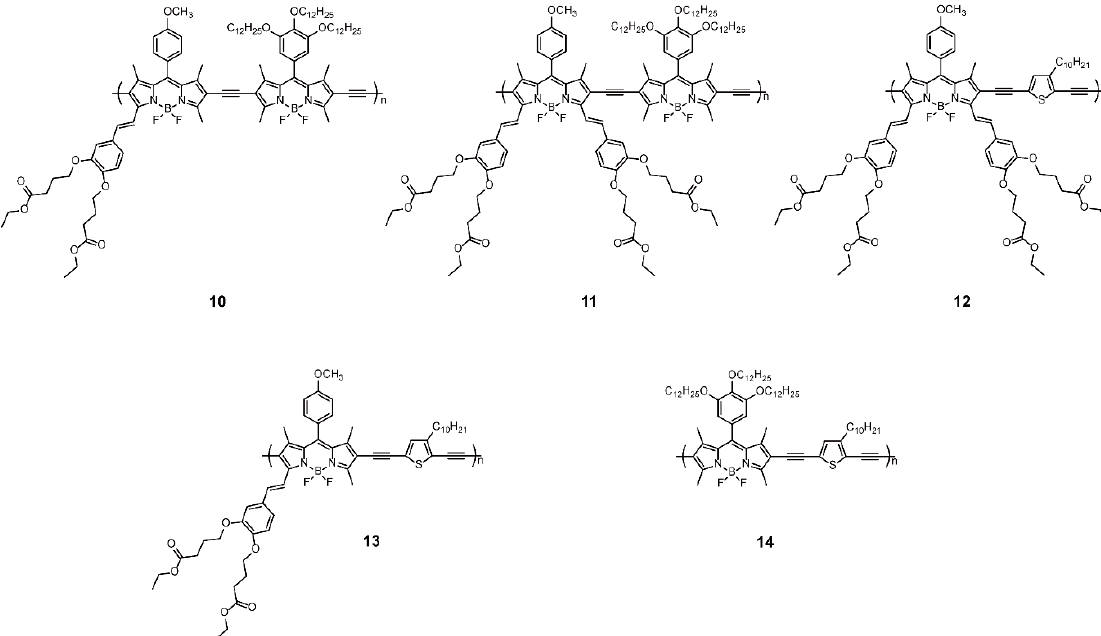
Figure 5. Chemical s tructures of polymers 15 and 16 ( Reproduced with permission from Reference [40]. Copyright @ 2014, American Chemical Society). The most common and patterned approach to developing novel polymer materials containing BODIPYs is selecting the appropriate comonomers to facilitate intra-molecular charge transfer excitation [41–47]. To precisely predict the performance of alternating co- polymers containing BODIPYs, Thayumanavan and coworkers [48] chose five aromatic groups with different electron-donating capacity (including fluorene ( 17 ), carbazole ( 18 ), bithiophene ( 19 ), cyclopentadithiophene ( 20 ), and dithienopyrrole ( 21 )) to copolymerize with BODIPYs and investigated the influence of comonomers on the properties of the en- suing polymers 17–21 (Figure 6), especially the frontier molecular orbital energy levels.